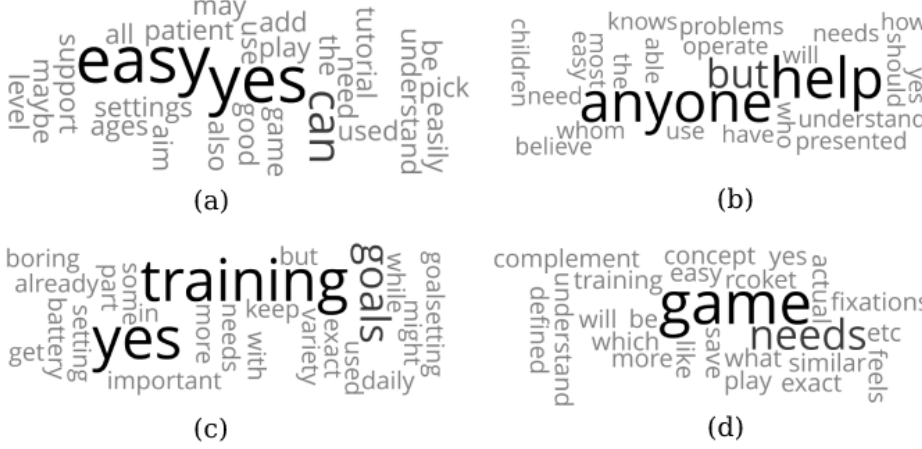
Figure 9. Word clouds generated from the answers to each of the four questions.